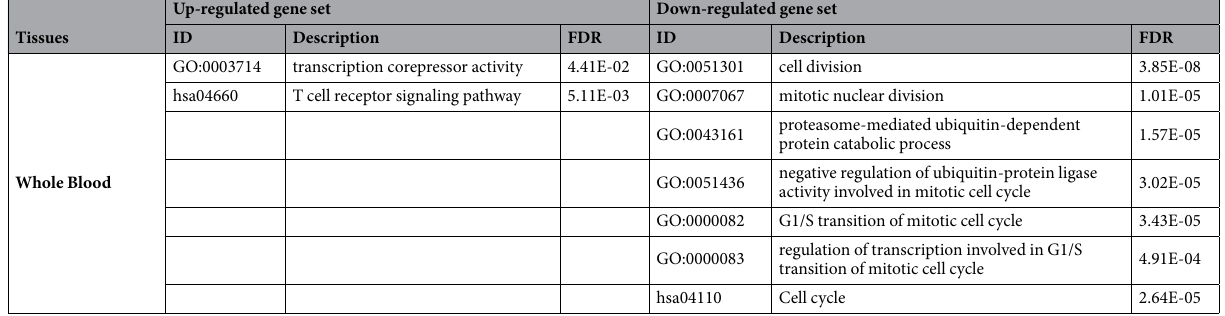
Table 2. Function enrichment of up- and down-regulated PMI-associated genes in eight human